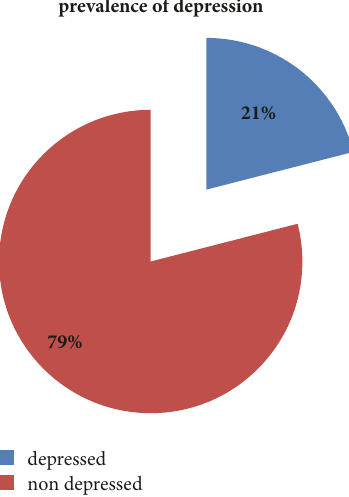
Figure 1: Prevalence of depression among asthma patients at governmental hospitals Addis Ababa, Ethiopia,